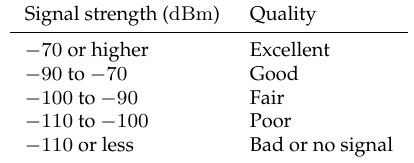
Table 1: Indication of quality for signal strength in 4G